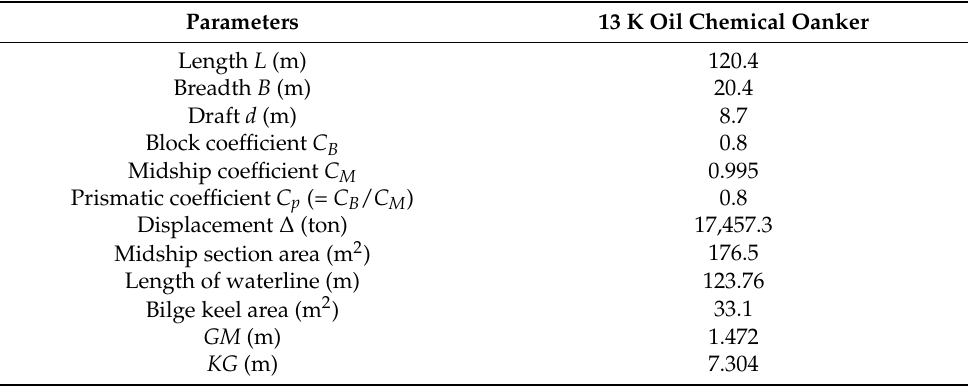
Table 4. Main dimensions of 13 K oil chemical tanker [14].